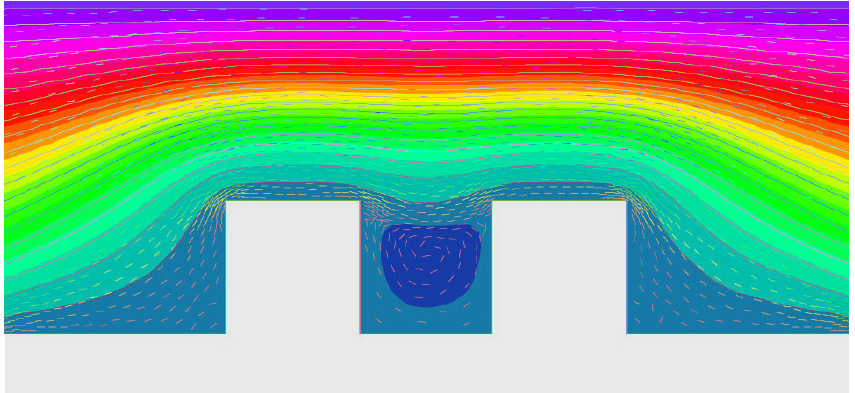
Figure 4. Streamlines for D =